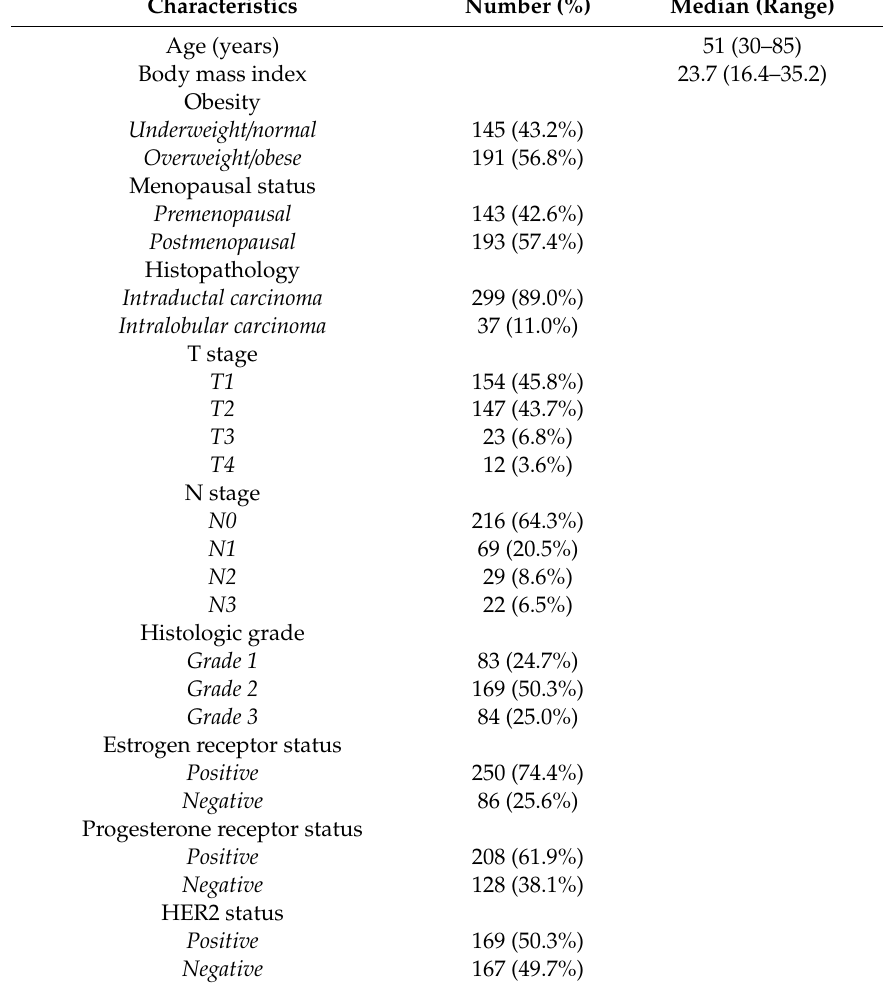
Table 1. Characteristics of enrolled female patients with breast cancer ( n =